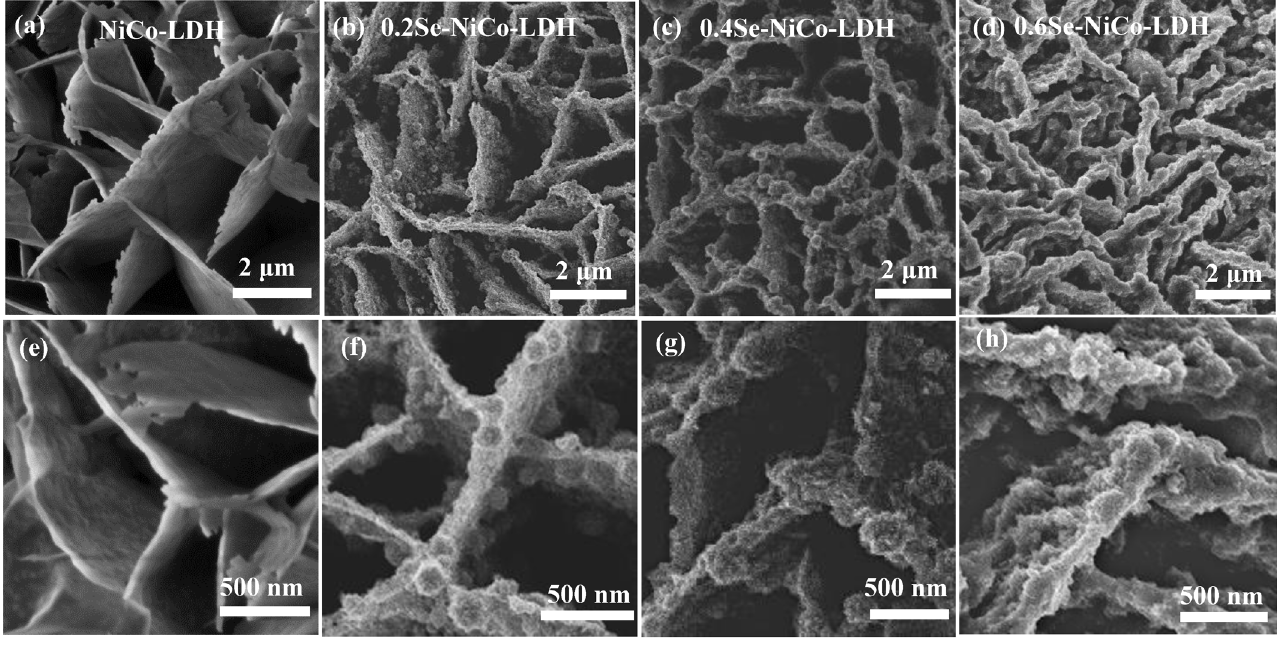
Figure 2. Morphology characterization. ( a – d ) Low-magnification SEM images; ( e – h ) high-magnification SEM images. SEM